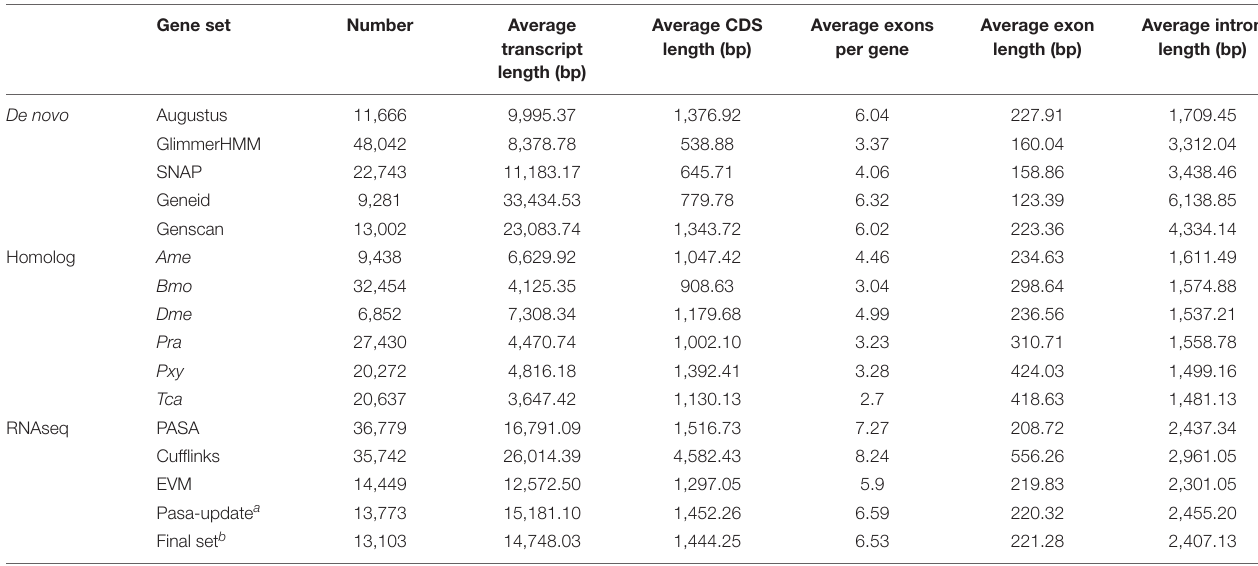
TABLE 4 | Statistics of gene structure